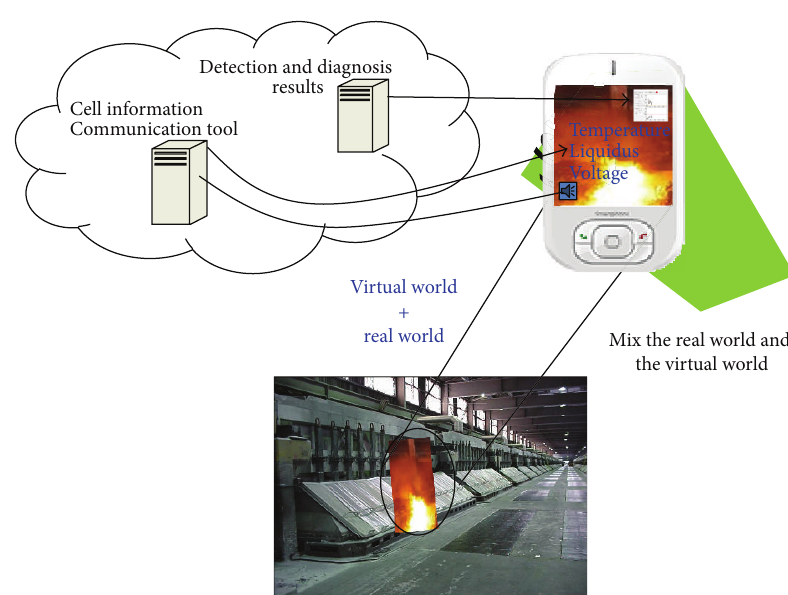
Figure 8: Abnormalities potentially generate a distinct view within an aluminium reduction cell. The combination of this view and current information of the cell can be used as a guideline to diagnose